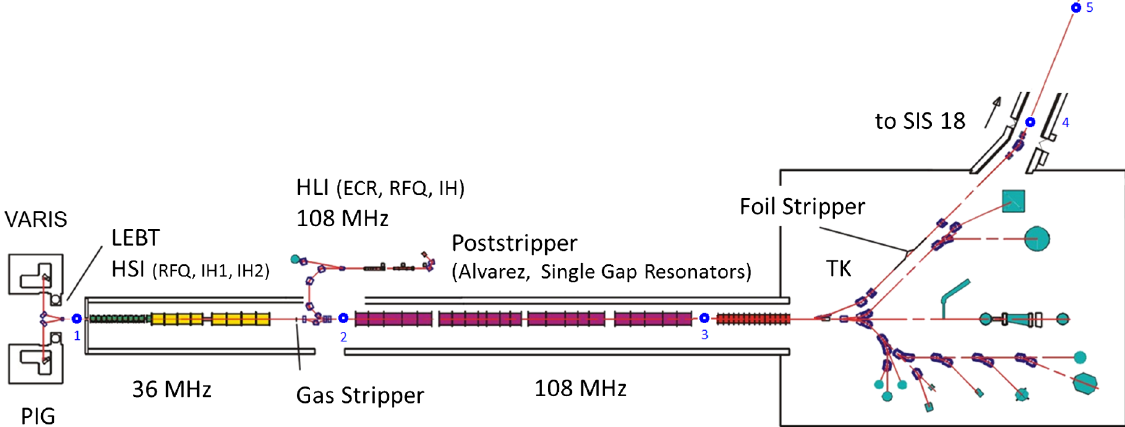
FIG. 1. GSI-UNILAC; the slit-grid-emittance measuring devices are shown in blue. 1, LEBT/UH1; 2, gas stripper section or US4; 3, poststripper or UA4; 4, transfer line or TK5; 5, transfer line or TK8.